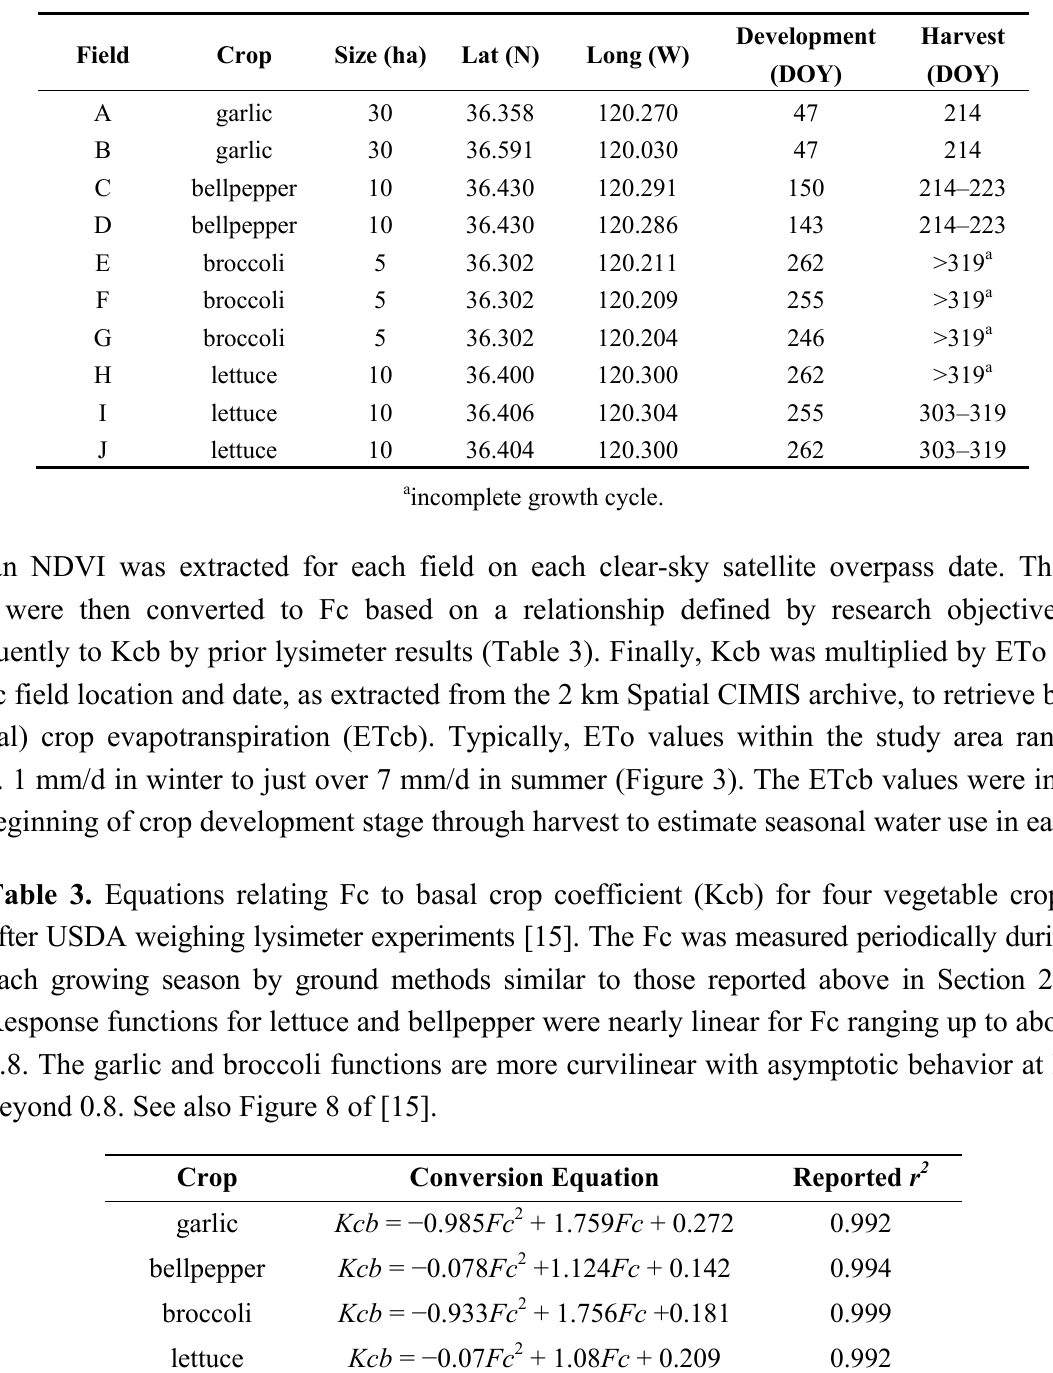
Table 2. Fields used for crop-cycle monitoring, with satellite image based estimates of development stage start and harvest day-of-year. Harvest date uncertainty for fields C, D, I, and J was due to lack of cloudfree satellite